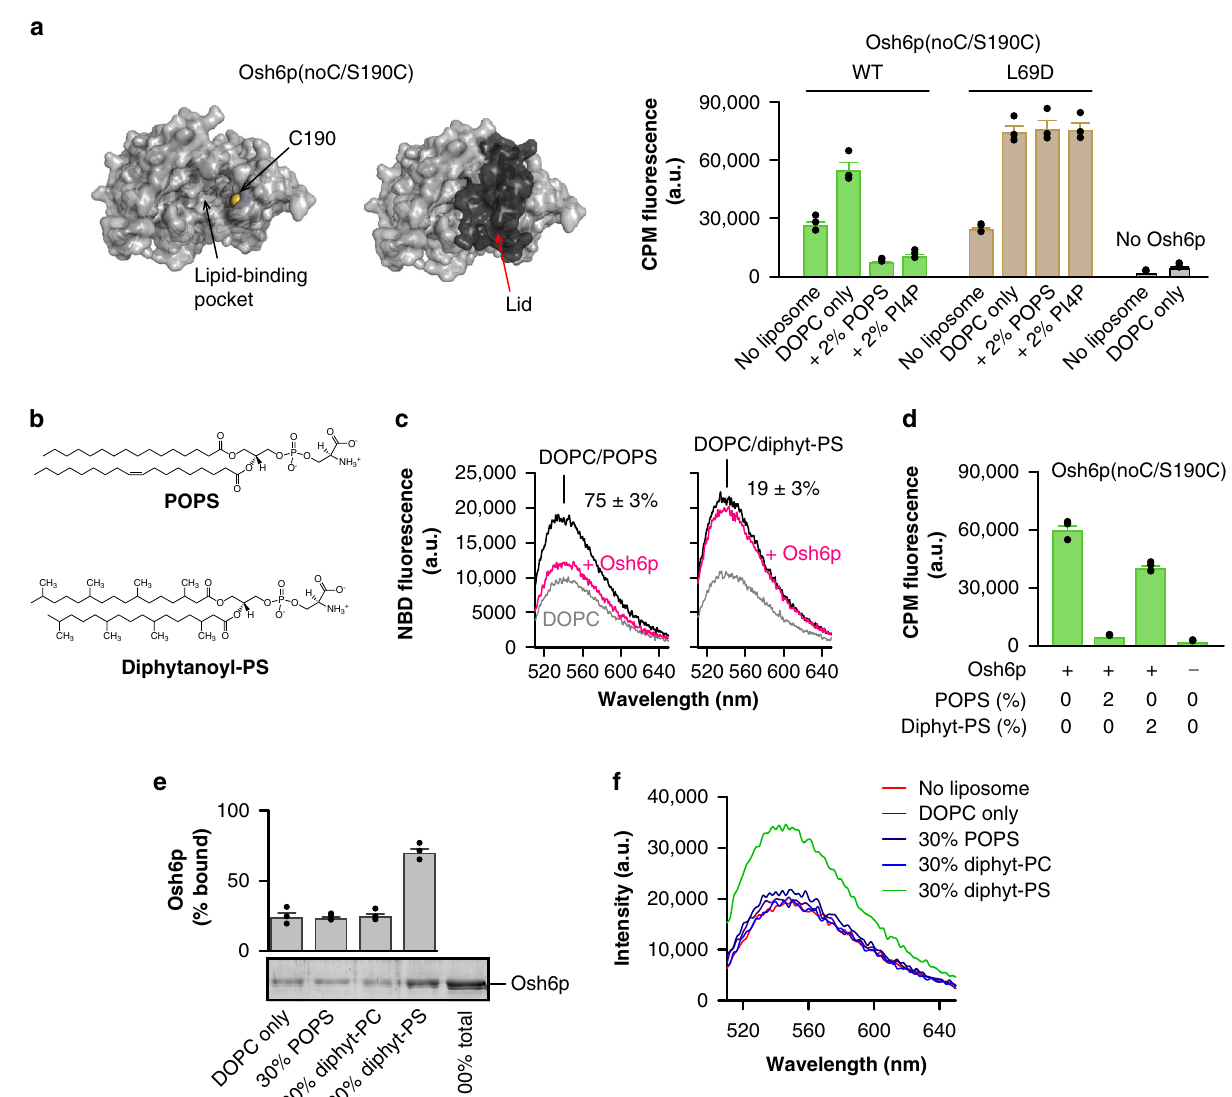
Fig. 3 The binding of Osh6p to anionic membranes depends on its conformational state. a Accessibility CPM assay. Osh6p(noC/S190C) has a unique cysteine which is solvent-accessible only if the lid is open. Osh6p(noC/S190C) or its L69D counterpart (400 nM) was incubated in HK buffer at 30 °C with DOPC liposomes (400 µ M lipids) including or not 2% POPS or diC16:0-PI4P. CPM (4 µ M) was added and the apparition of fl uorescence was measured over time. Bars correspond to the fl uorescence (measured at λ = 470 nm) 30 min after adding CPM ( n = 3). b Chemical structure of POPS and diphytanoyl-PS. c PS extraction assay. Fluorescence spectra of NBD-C2 Lact (250 nM) ( λ ex = 460 nm), mixed with DOPC liposomes (80 µ M lipid) incorporating 2% POPS or 2% diphytanoyl-PS, were recorded before and after adding Osh6p (3 µ M). A control experiment was done with pure DOPC liposomes. Normalized signal provides the fraction (in percentage) of extracted PS ( n = 4 with POPS, n = 3 with diphytanoyl-PS). d Accessibility assay. Osh6p(noC/S190C) (400 nM) was incubated with DOPC liposomes doped or not with 2% POPS or diphytanoyl-PS and mixed with CPM (4 µ M). Intensity bars correspond to the fl uorescence measured 30 min after adding CPM ( n = 3). e Flotation assay. Osh6p (750 nM) was incubated with pure DOPC liposomes (750 µ M lipids) or liposomes containing 30% POPS, diphytanoyl-PC or diphytanoyl-PS at the expense of DOPC. The bars represent the fraction of protein bound to each type of liposomes ( n = 3 – 4). f Emission spectra of NBD-labeled Osh6p (200 nM, excitation at 460 nm) in HK buffer measured in the absence (red spectrum) or presence of liposomes (400 µ M total lipids) made only of DOPC or including 30% POPS, diphytanoyl-PC or diphytanoyl-PS (at the expense of DOPC). The contribution of buffer alone or of light scattering from liposomes to the fl uorescence signal was subtracted. Error bars correspond to s.e.m. Source data are provided as a Source Data fi